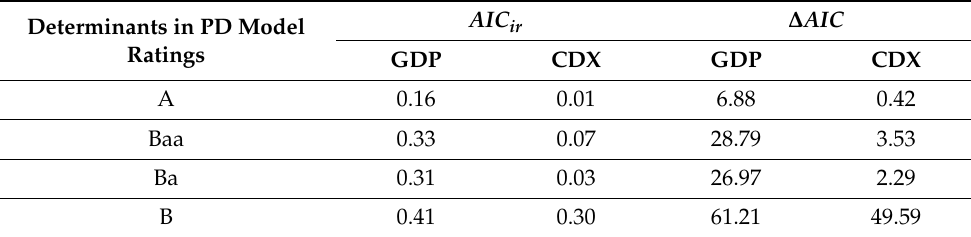
Table 2. AIC ir and ∆ AIC for the PD model with a GDP determinant versus the PD model with a CDX